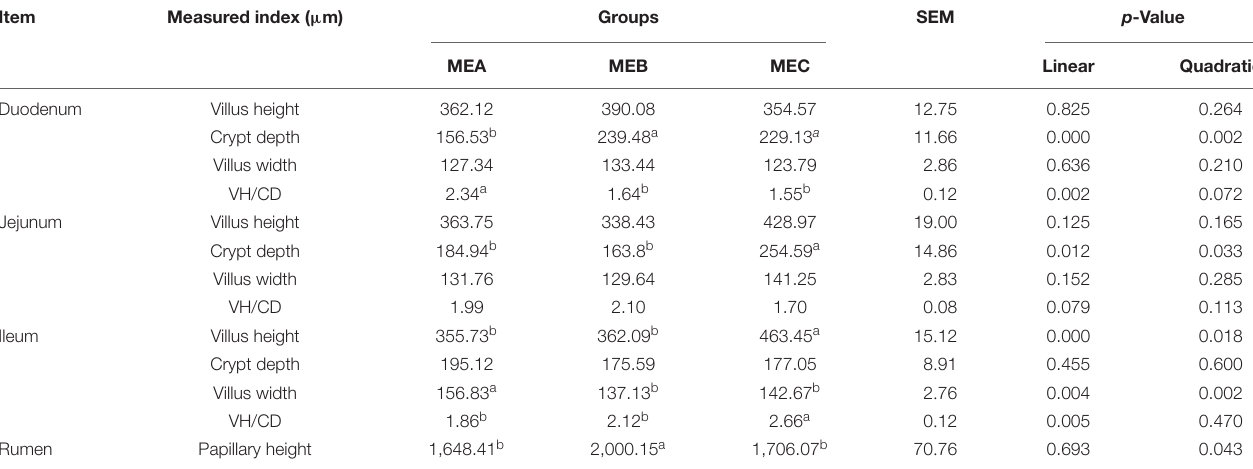
TABLE 3 | Effects of dietary energy levels on GIT